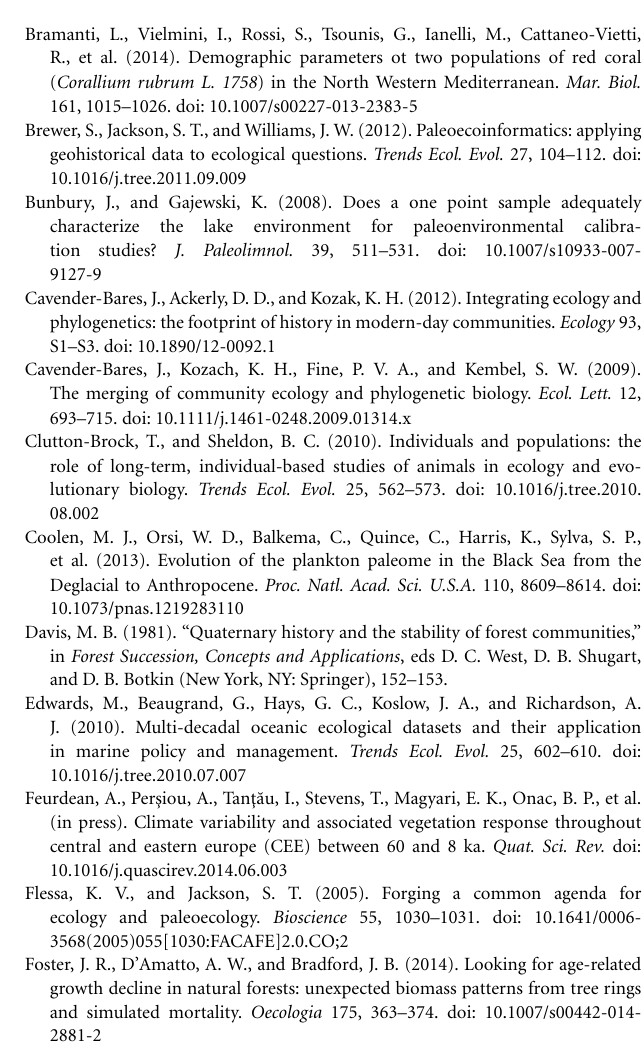
FIGURE 2 | Northern Hemisphere temperature reconstructions of the last millennium. Palaeorecords are based on tree rings and ice cores, present-day records are from instrumental measures.